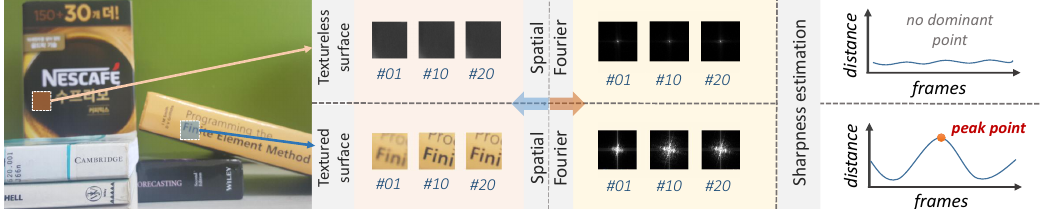
Figure 8. Choosing peak-point(best-focused frame) of normalized absolute difference between the reference frame and all other frames from textured and textureless parts of the